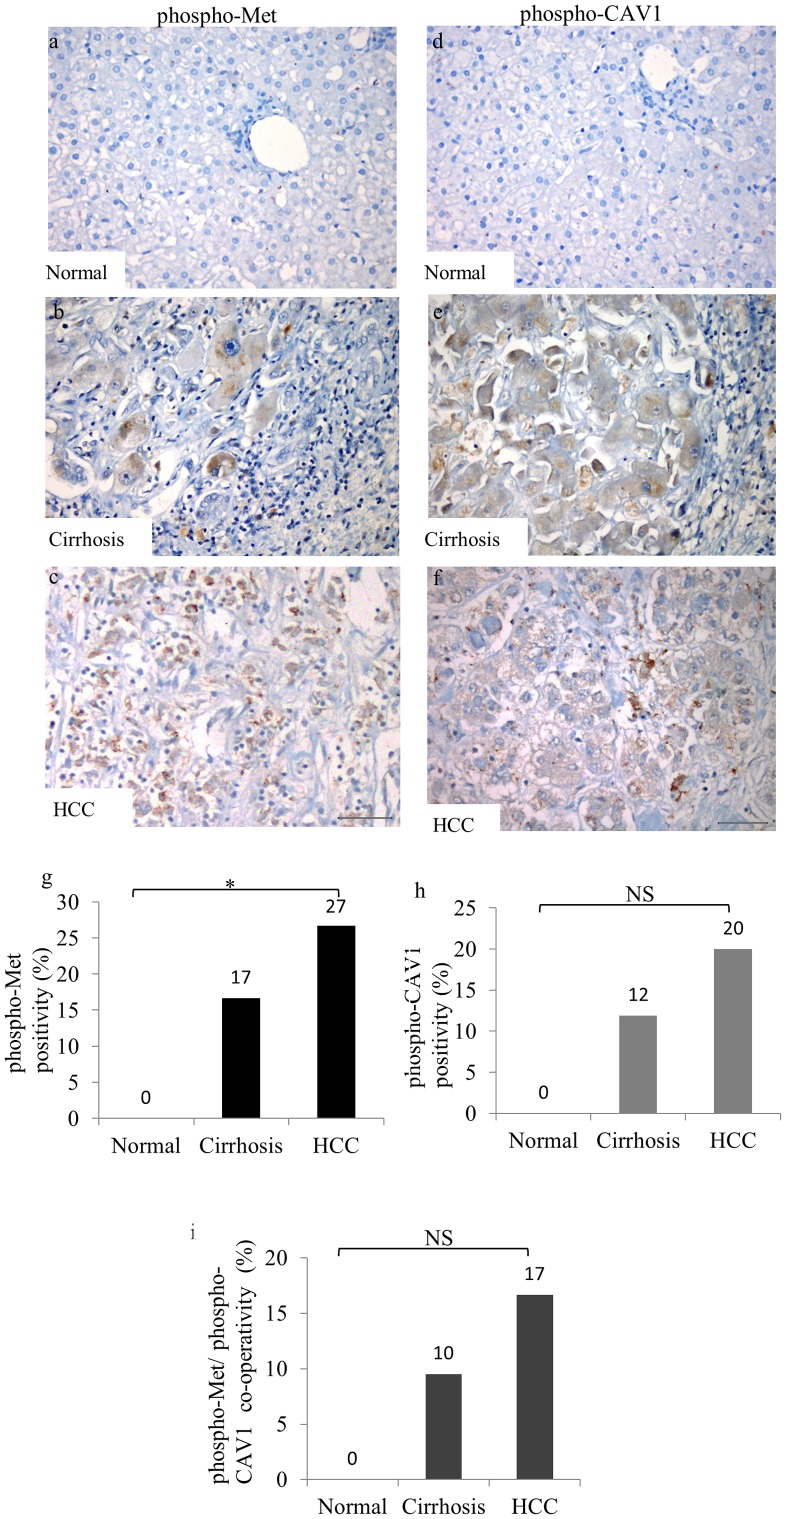
Immunohistochemical assesment of phospho-Met and phospho-CAV1 expressions in normal, cirrhotic and HCC tissues.Negative phosphor-Met expression in normal hepatocytes (a), cirrhotic liver tissue showed weak, phospho-Met staining (b). HCC displayed intense phospho-Met staining. Each column represents histologically classified liver tissues (normal liver, cirrhotic liver, HCC) with the height representing the ratio of positive staining for phospho-Met (d). Negative phospho-CAV1 expression in normal liver tissue (e), diffuse phospho-CAV1 staining in hepatocytes in the cirrhotic liver tissue (g), HCC displayed strong phospho-CAV1 staining (h). Comparison of the ratios of positive staining for phospho-CAV1 in normal liver, cirrhotic liver, and HCC tissues. Each column represents the immunoreactivity of both phospho-Met and phospho-CAV1 in the same liver tissue samples (i). Trend in χ2-test was performed to determine the trend between groups (*p<0,05, NS: not significant, Bar = 200 µm).